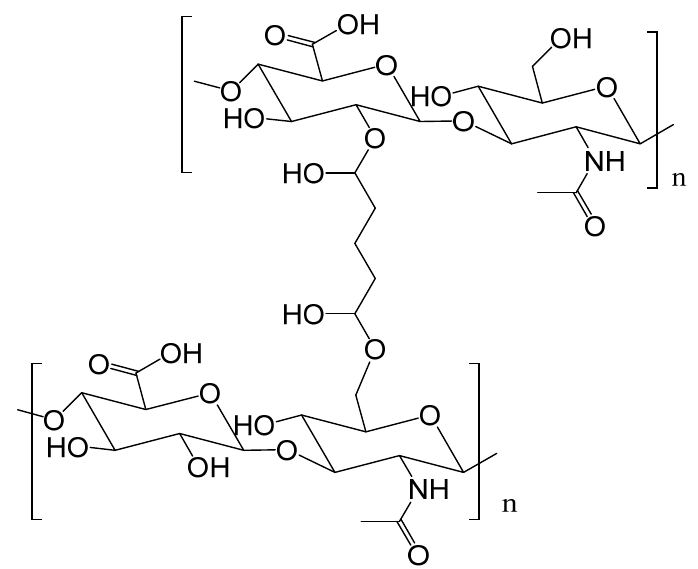
Scheme 2. Crosslinking reaction using divinyl